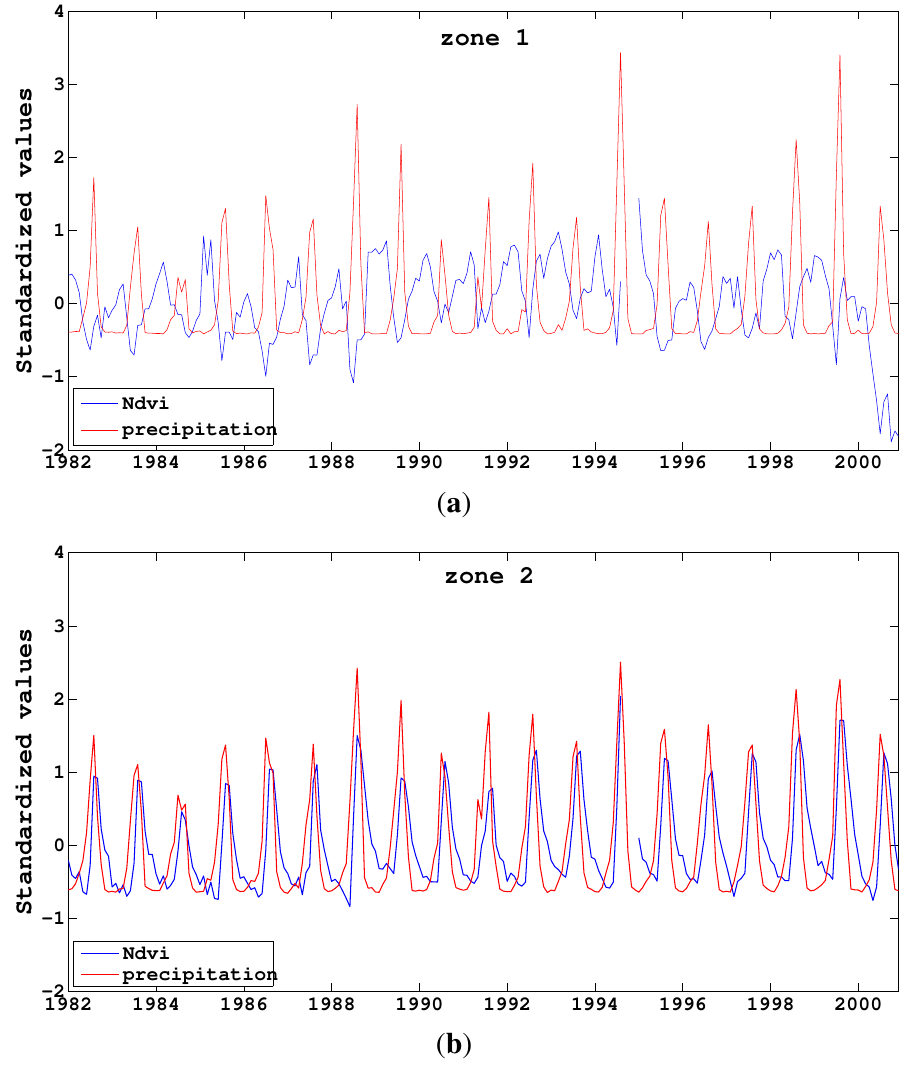
Figure 2. Interannual variability of monthly averages of Normalized Difference Vegetation Index (NDVI) (blue solid line) and precipitation (red solid line) for the 1982–2000 period over each vegetation type. ( a ) Zone 1, ( b ) zone 2 , ( c ) zone 3 and ( d ) zone